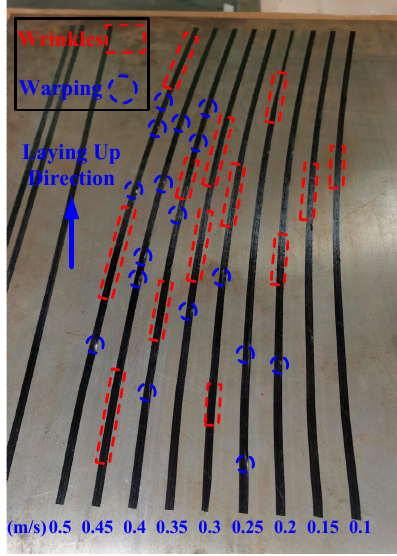
Figure 16. Results of experiment with different layup rates.